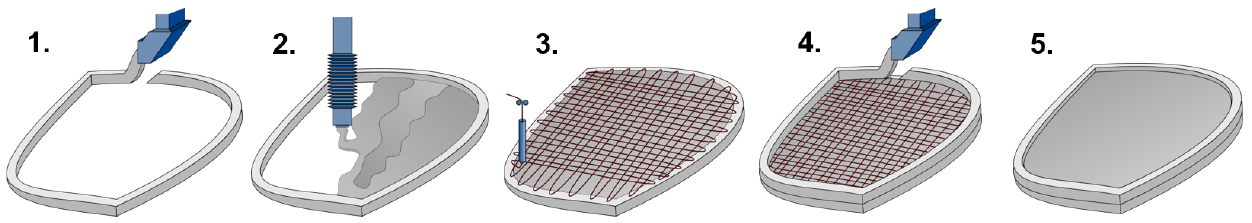
Figure 1. Steps of module production in the ACDC project: steps 1, 4—3D printing of the outer contour, steps 2, 5—infill with SCC by pumping, step 3—the creation of reinforcement